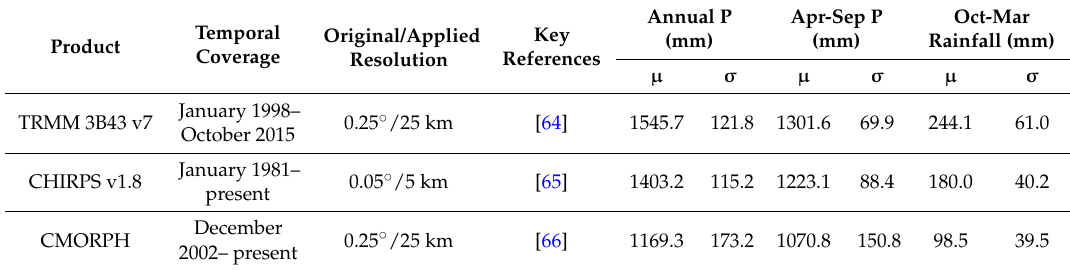
Table 1. Evaluated rainfall GSDPs for the Red River Basin. The basin-wide mean rainfall ( μ ) and